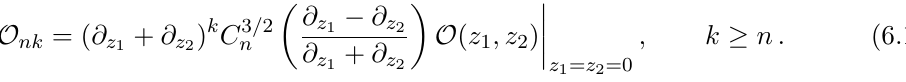
Figure 2 . Invariant functions (cid:31) inv ( (cid:28) ) (left panel) and (cid:31) P LO result (short dashes) is shown together with the NLO (long dashes) and NNLO (solid curves). The NNLO results using exact O ( a 3 ) functions obtained by the numerical integration of eq. (5.8) are shown by black dots for